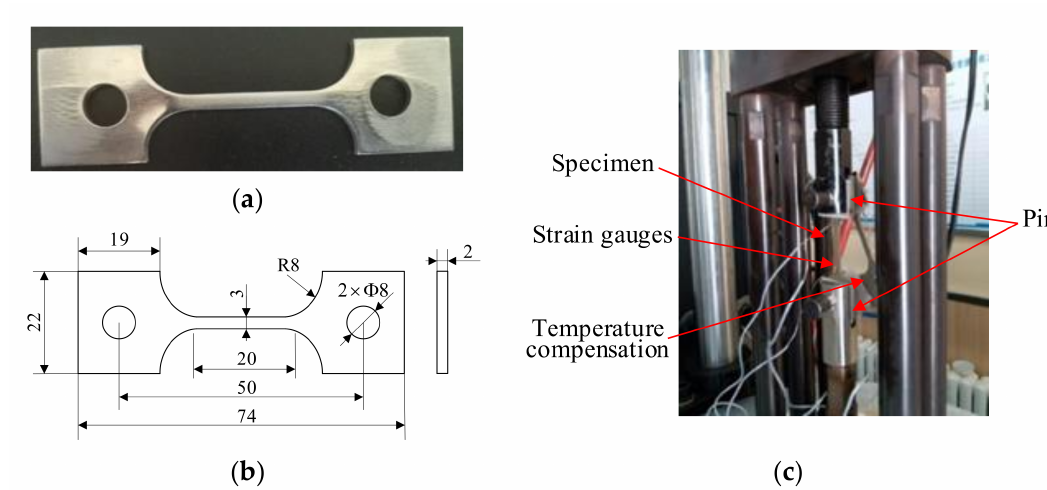
Figure 6. Material tensile test. ( a ) Tensile specimen, ( b ) the size of tensile specimen and ( c ) clamping of tensile specimen.